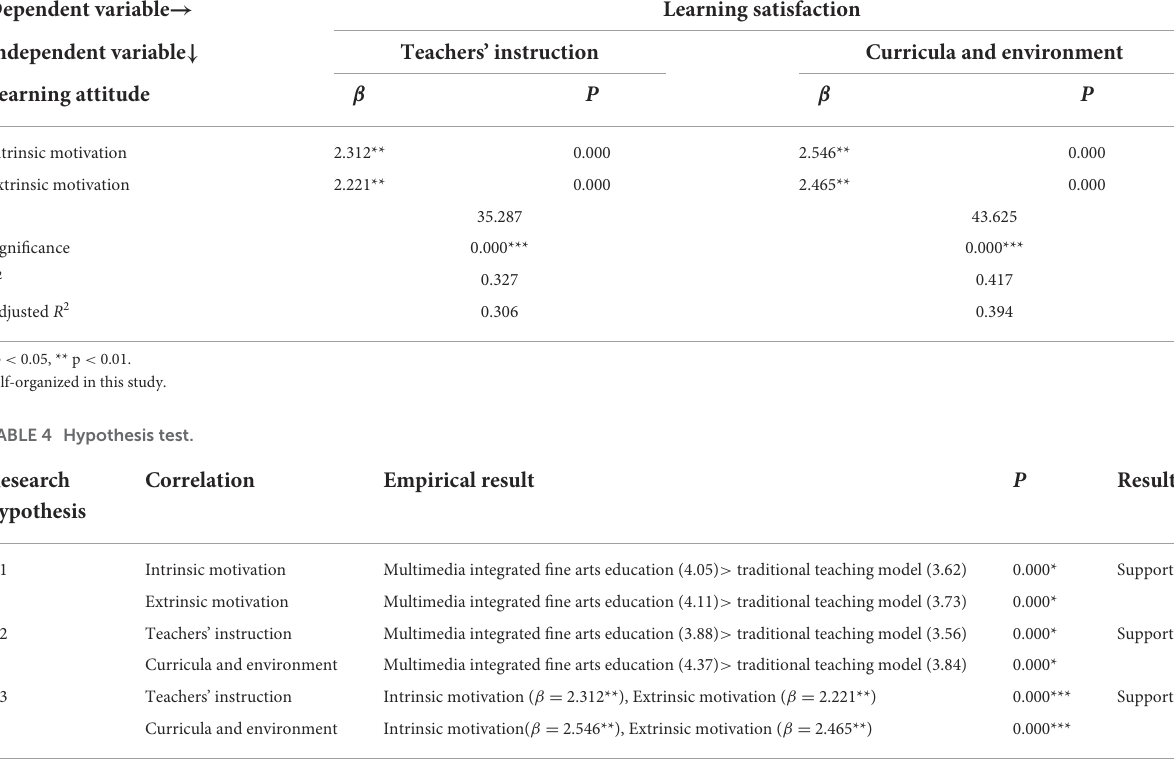
TABLE 3 Analysis of learning attitude to learning satisfaction.